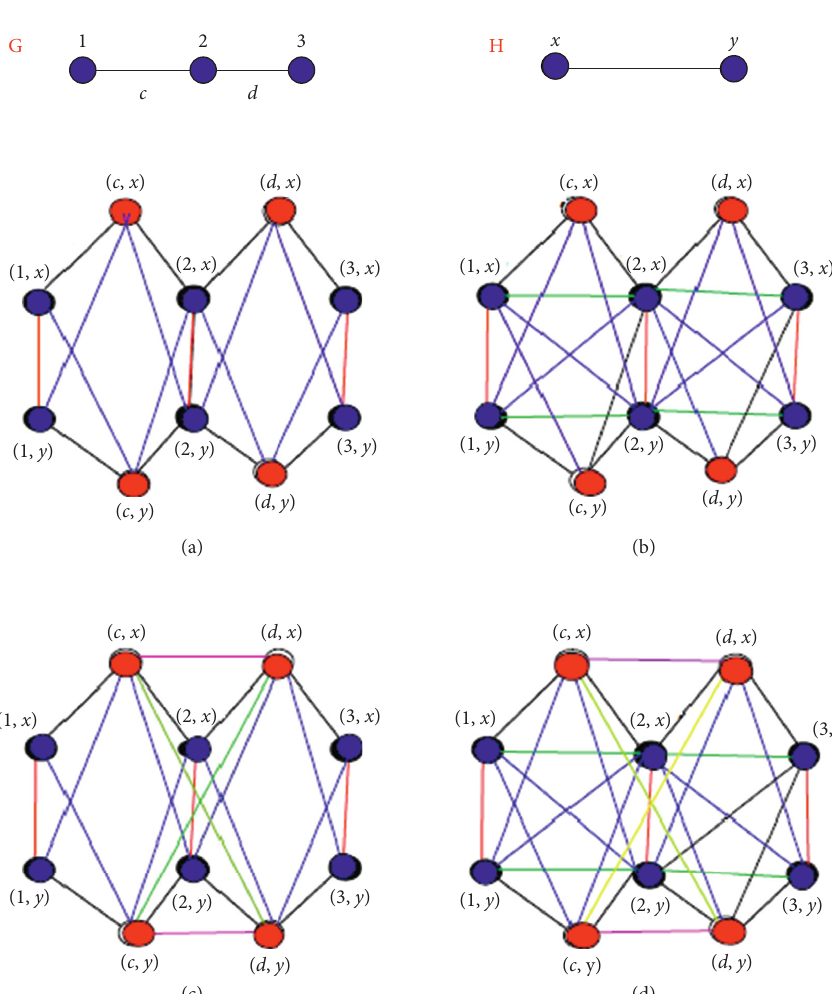
Figure 2: For G � P